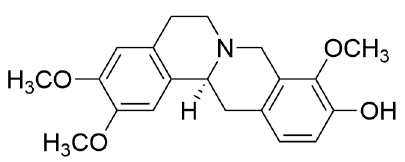
Figure 1. Chemical structure of levo -corydalmine ( l -CDL).